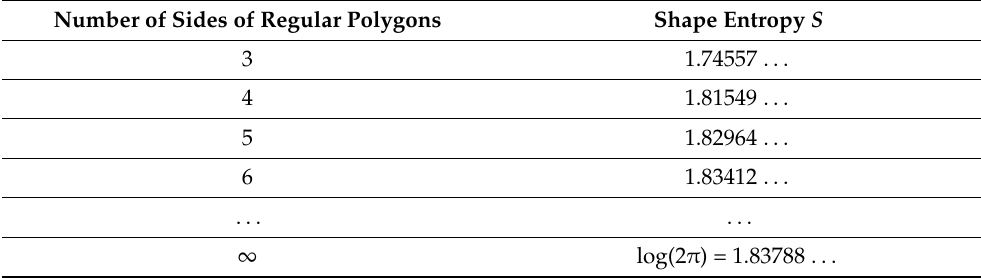
Table 1. The shape entropies of regular polygons.